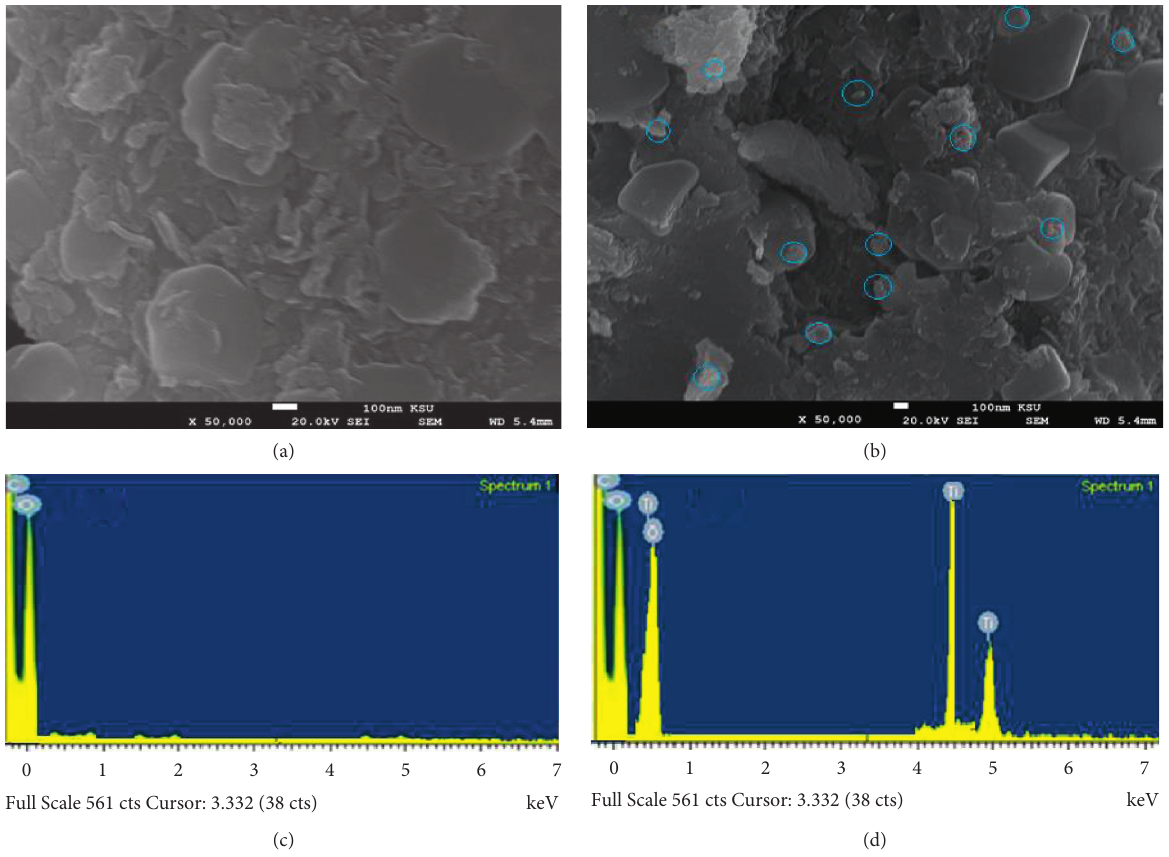
Figure 6: SEM images of (a) PEG and (b) TiO 2 nanoparticles dispersed in the polymeric P. cylindraceus oil-TiO 2 -PEG bionanocomposite and EDX spectra of (c) PEG and (d) polymeric P. cylindraceus oil-TiO 2 -PEG bionanocomposite.